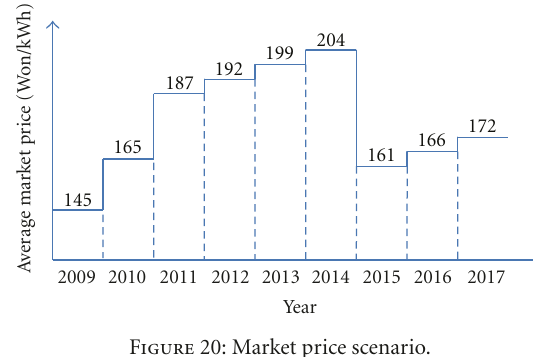
Figure 22: Expected production costs of solar